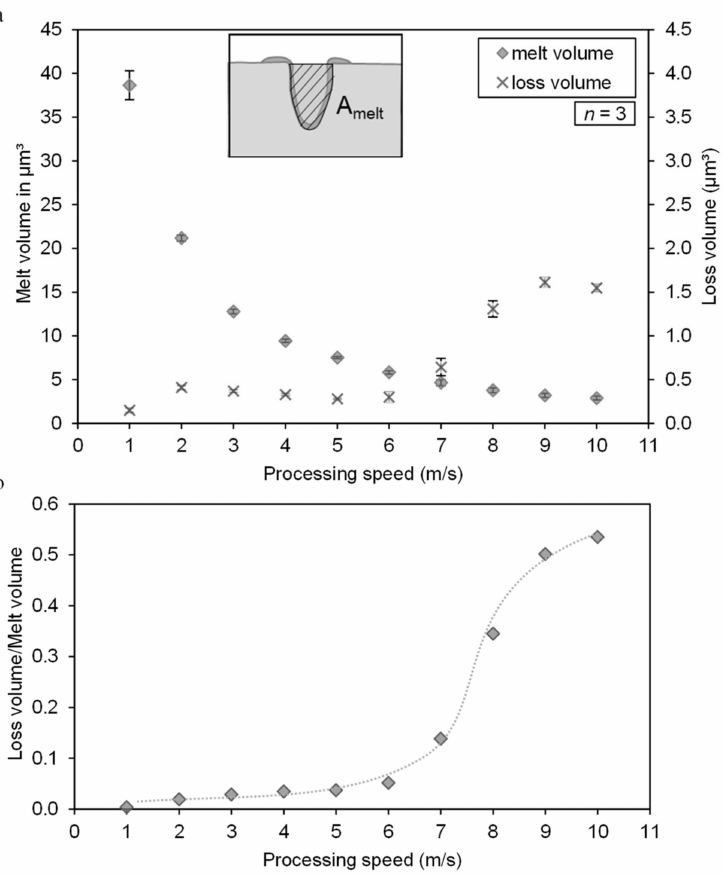
Figure 3. ( a ) Melt volume and calculated loss volume; ( b ) ratio of loss volume to melt